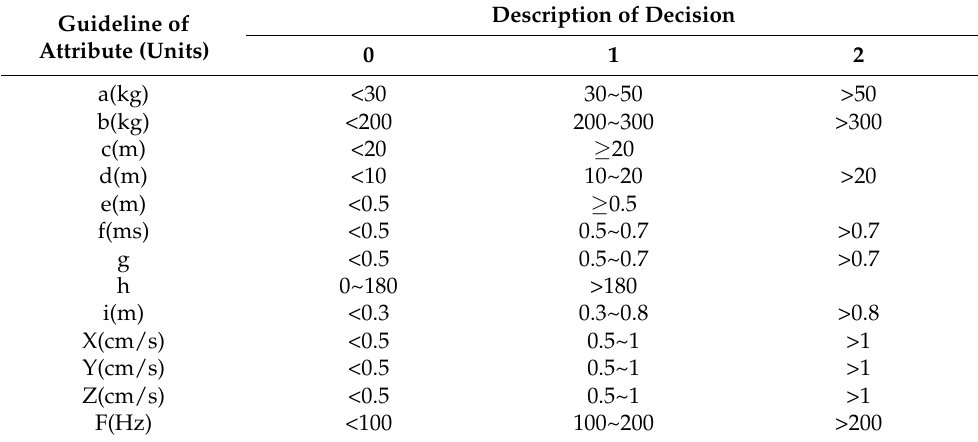
Table 2. The reduction of decision and